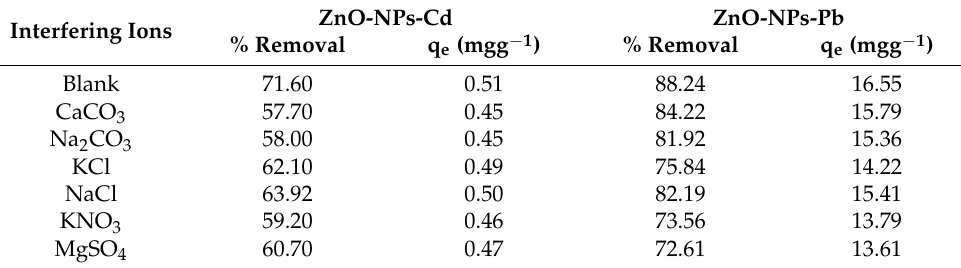
Table 3. Effect of competing ions on the adsorption capacity.